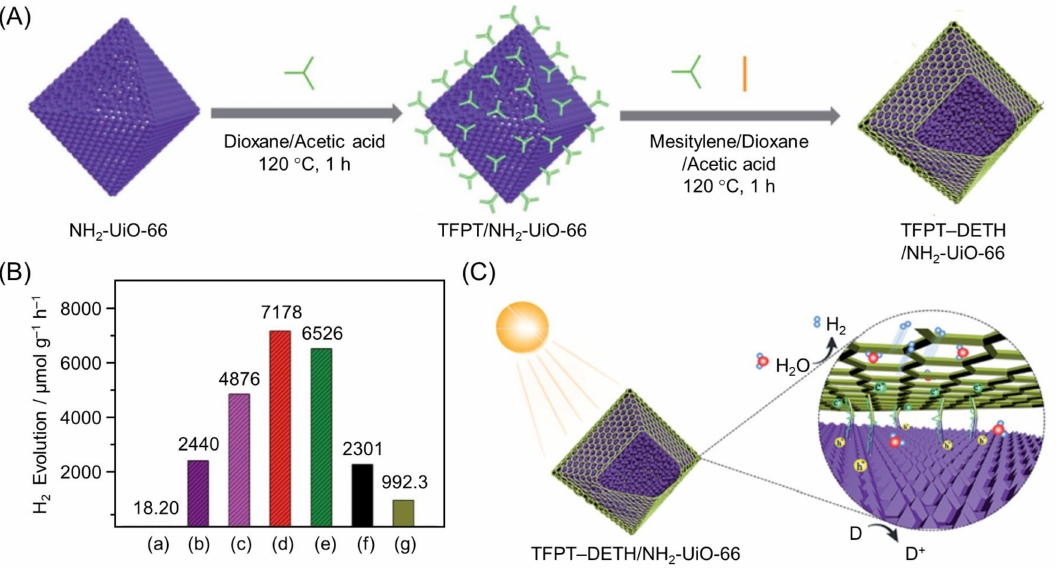
Figure 15. ( A ) Schematic illustration of the synthetic process of TFPT–DETH/NH 2 -UiO-66 core–shell hetero-frameworks. ( B ) Corresponding HER rates of photocatalysts using phosphate-buffered saline buffer solution (pH = 7.4) containing 100 mg of sodium ascorbate as a sacrificial electron donor, and Pt NPs (7.5 wt%) as a cocatalyst, under Vis-light irradiation ( λ ≥ 420 nm, Xe lamp): (a) NH 2 - UiO-66, (b–e) TFPT–DETH/NH 2 -UiO-66 ( n ) samples ( n = 1, 2, 4, or 6), (f) TFPT–DETH, and (g) physical mixture of TFPT–DETH and NH 2 -UiO-66 (TFPT–DETH:NH 2 -UiO-66 = 1:1). ( C ) Schematic illustration of photocatalytic H 2 evolution over the TFPT–DETH/NH 2 -UiO-66 ( n ) hetero-framework under Vis-light irradiation. In the figure, D denotes sodium ascorbate. Reproduced with permission from reference [154]. Copyright 2019 The Royal Society of